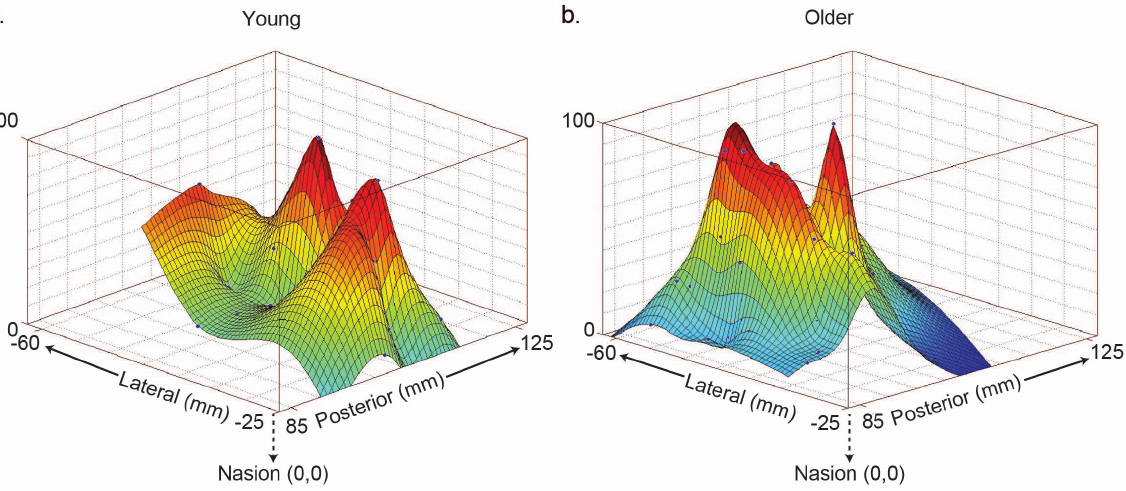
Figure 5. Age and corticospinal excitation. 5a,b shows 3-D function plots of the representative maps from a young and an old participant. These maps illustrate the spread of excitation across maps. Response densities did not significantly differ between age groups. The old subject has a response density of 25.39. The young subject has a response density of 21.63.